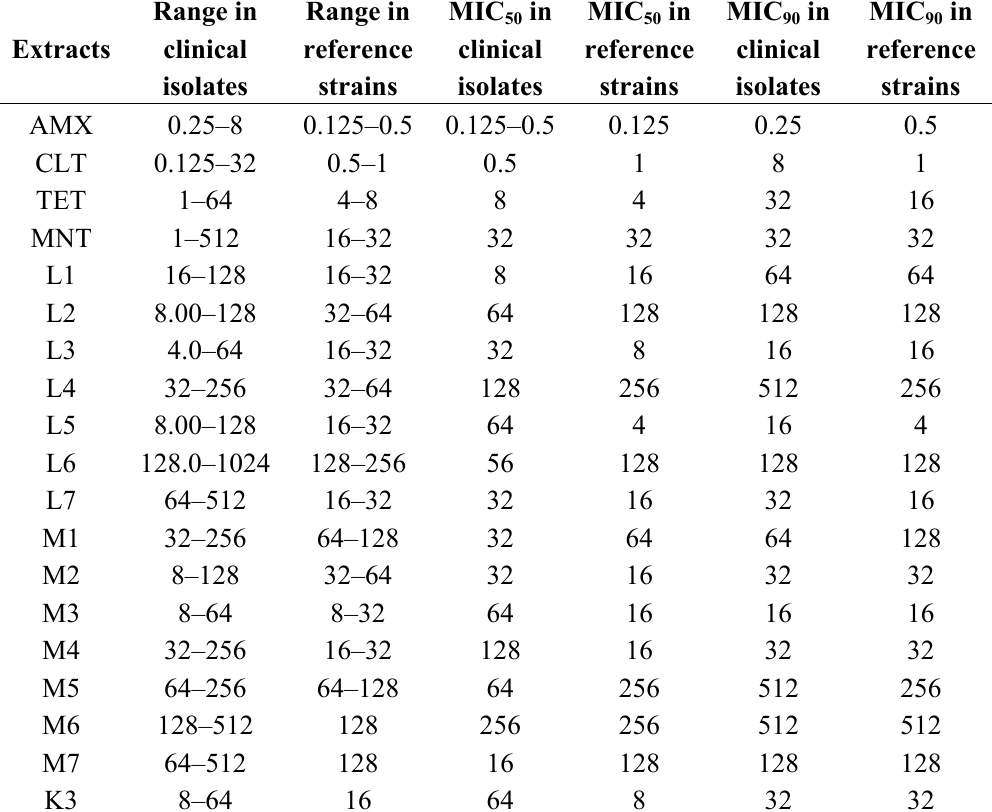
Table 2. Antibacterial activity (MICs values µg mL − 1 ) of plant extracts, AMX, CLT, MNZ and TET, against 40 clinical and two reference strains of H. pylori .